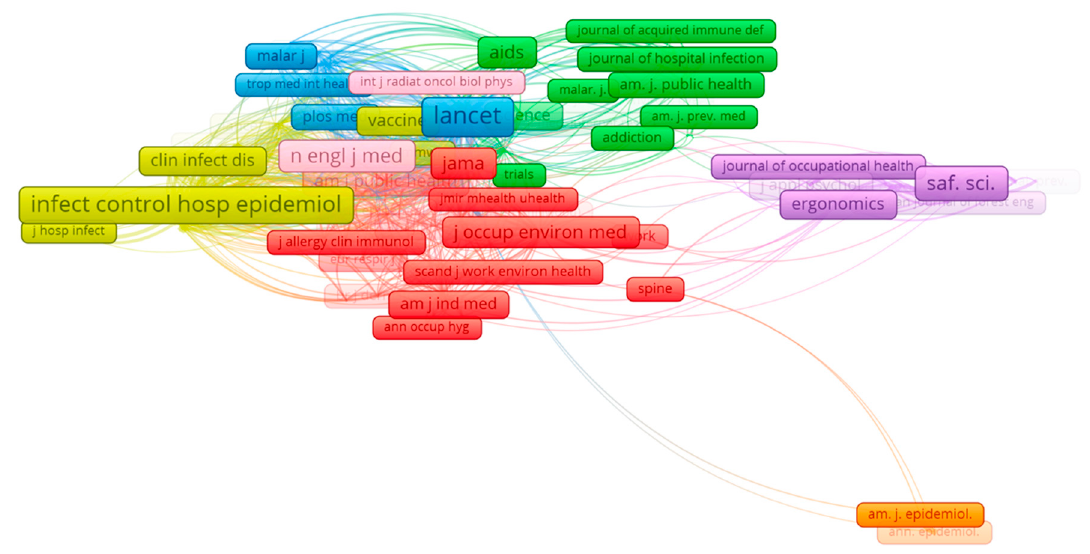
Figure 4. Co-citation between journals.